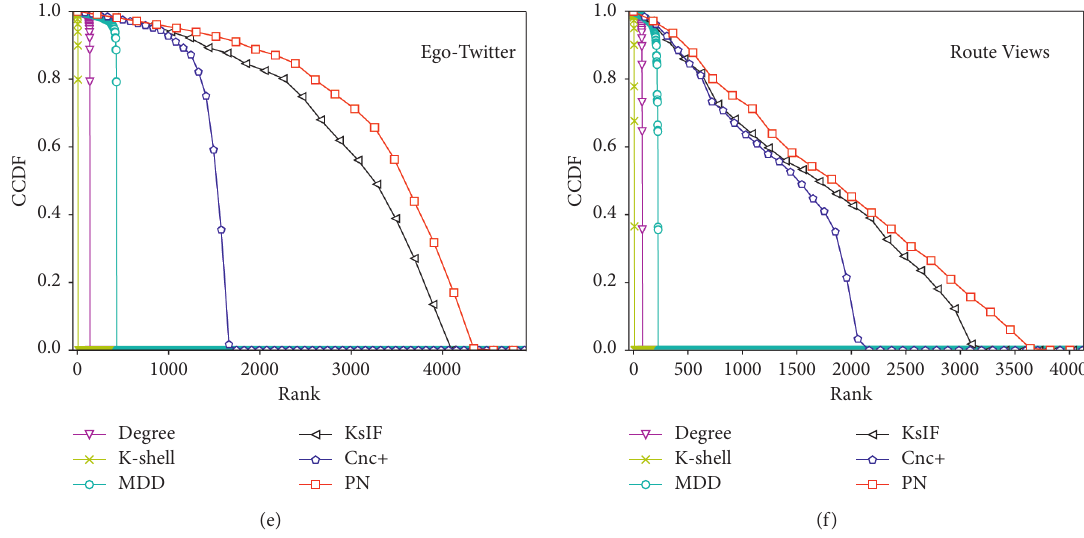
Figure 7: The complementary cumulative distribution (CCDF) of the six methods in six different datasets: CA-HepTh (a), Netscience (b), Cond-Mat (c), DNC email (d), Ego-Twitter (e), and Route Views